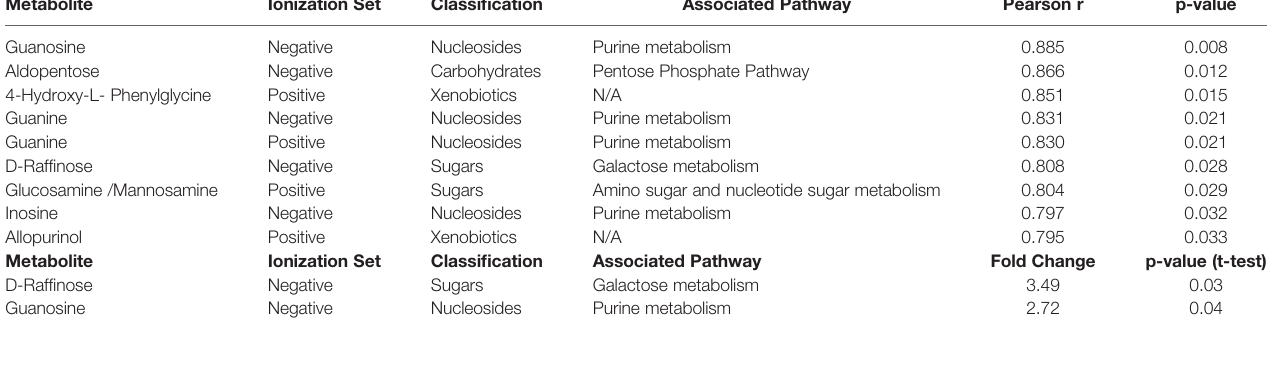
TABLE 3 | List of cellular metabolites signi fi cantly associated with cytarabine AUC values by Pearson correlation and categorical analysis in AML cell lines. Metabolite